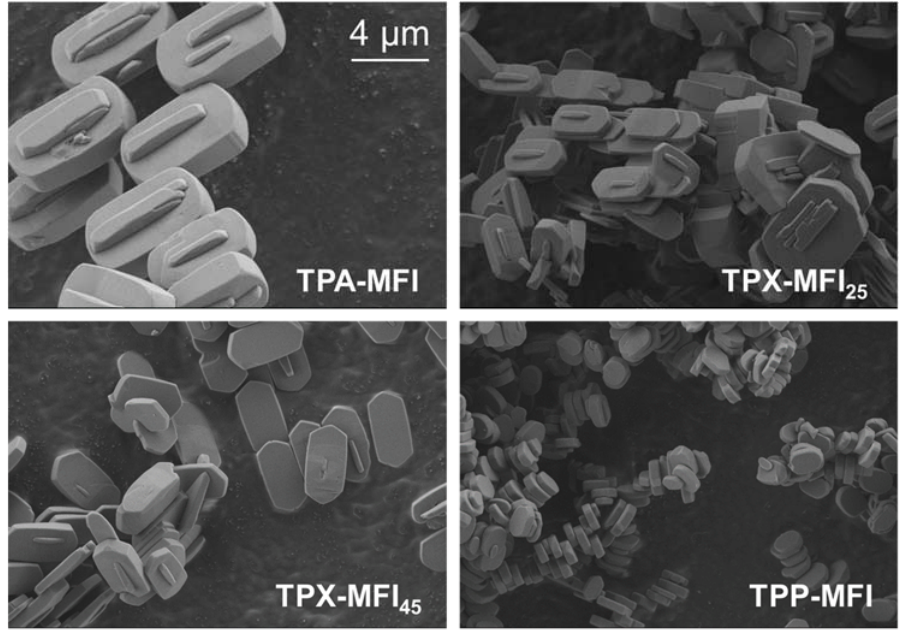
Figure 3. FESEM images of silicalite-1 samples synthesized using TPA, TPP, and mixtures of them as OSDAs. Scale bar stands for all images.